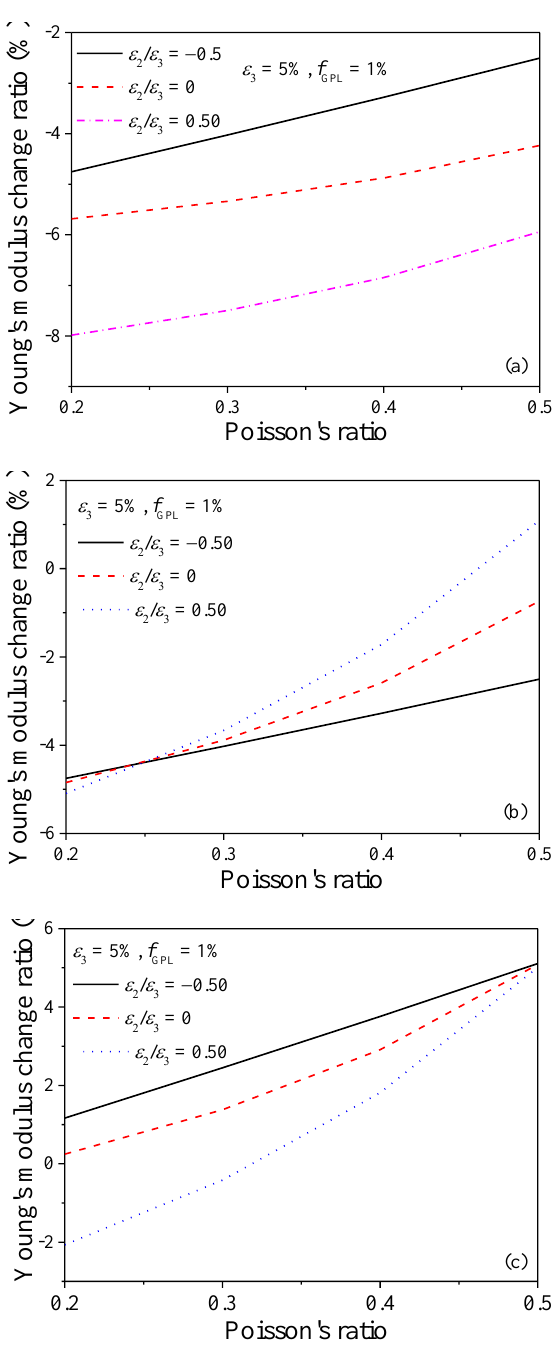
Figure 10. Effect of Poisson’s ratio on Young’s modulus change ratio of GPL/epoxy nanocomposites ( a ) X 1 -direction; ( b ) X 2 -direction; ( c ) X 3 -direction.